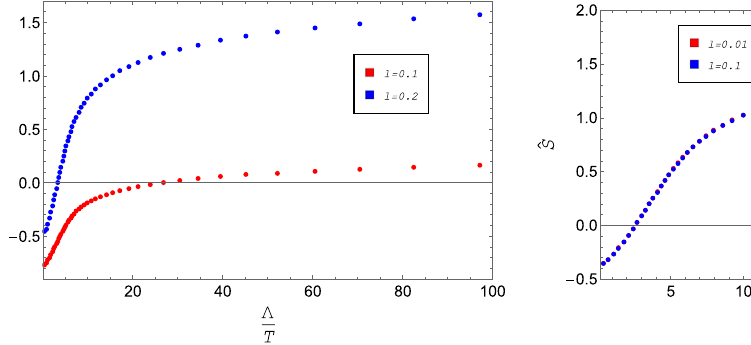
(cid:3) = 0 . 1 (red) and (cid:3) = 0 . 9 (blue) for fixed φ = 2. Right: Rescaled M disentangling transition x DT in terms of (cid:3) . We have fixed φ M = 2. In l all plots l = 0 . 1 for different l